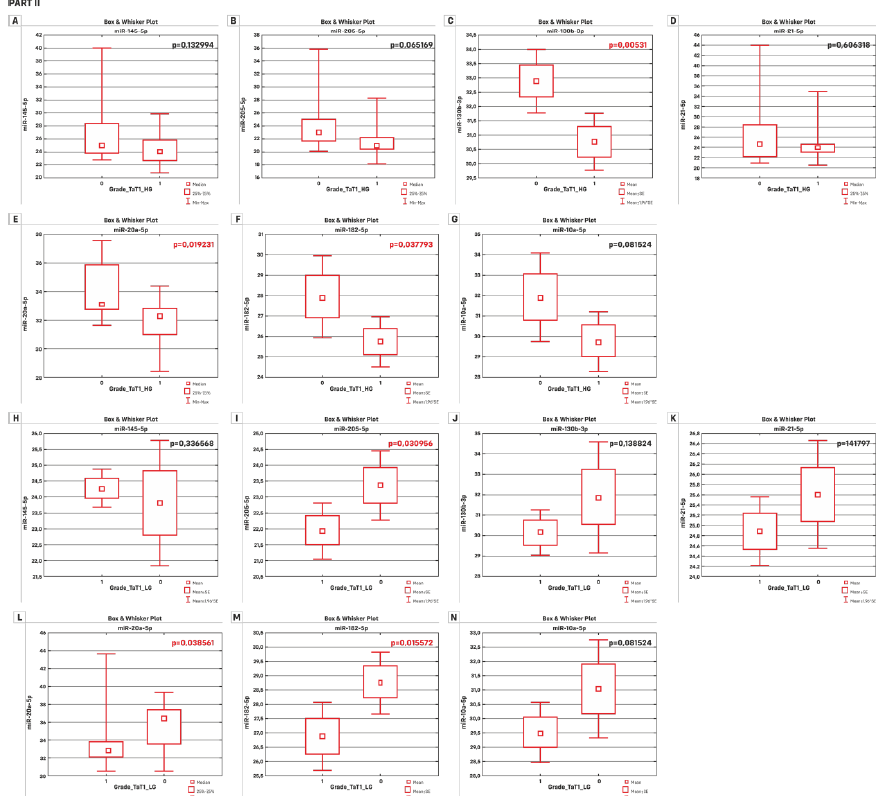
Figure 1. Differences in expression level for patients: Group 0—BC patients in T2; Group 1—BC patients in stage TaT1 or in low or high grade group (low grade (LG) or high grade (HG)). Part I presents results for the differentiation of patients in terms of grade in TaT1 ( A – G ) and T2 ( H – N ) groups. Only miR-130b-3p differentiated patients in stage TaT1 according to grade (miR-145-5p was close to significance). Part II presents results for the differentiation of patients in terms of stage in high ( A – G ) or low grade ( H – N ) groups. If we take patients with LG, the di ff erentiating miRNAs in terms of stage were miR-205-5p, miR-20a-5p and miR-182-5p. In the case of patients in the HG group, miR-20a-5p, miR-205-5p and miR-182-5p always had significantly lower values of expression in patients in the TaT1 stage of the disease compared to patients in the T2 stage. ( A ) and ( H ) miR-145-5p; ( B ) and ( I ) miR-205-5p; ( C ) and ( J ) miR-130b-3p; ( D ) and ( K ) miR-21-5p; ( E ) and ( L ) miR-20a-5p; ( F ) and ( M ) miR-182-5p; and ( G ) and ( N ) miR-10a-5p. p -values in read are significant ( p <